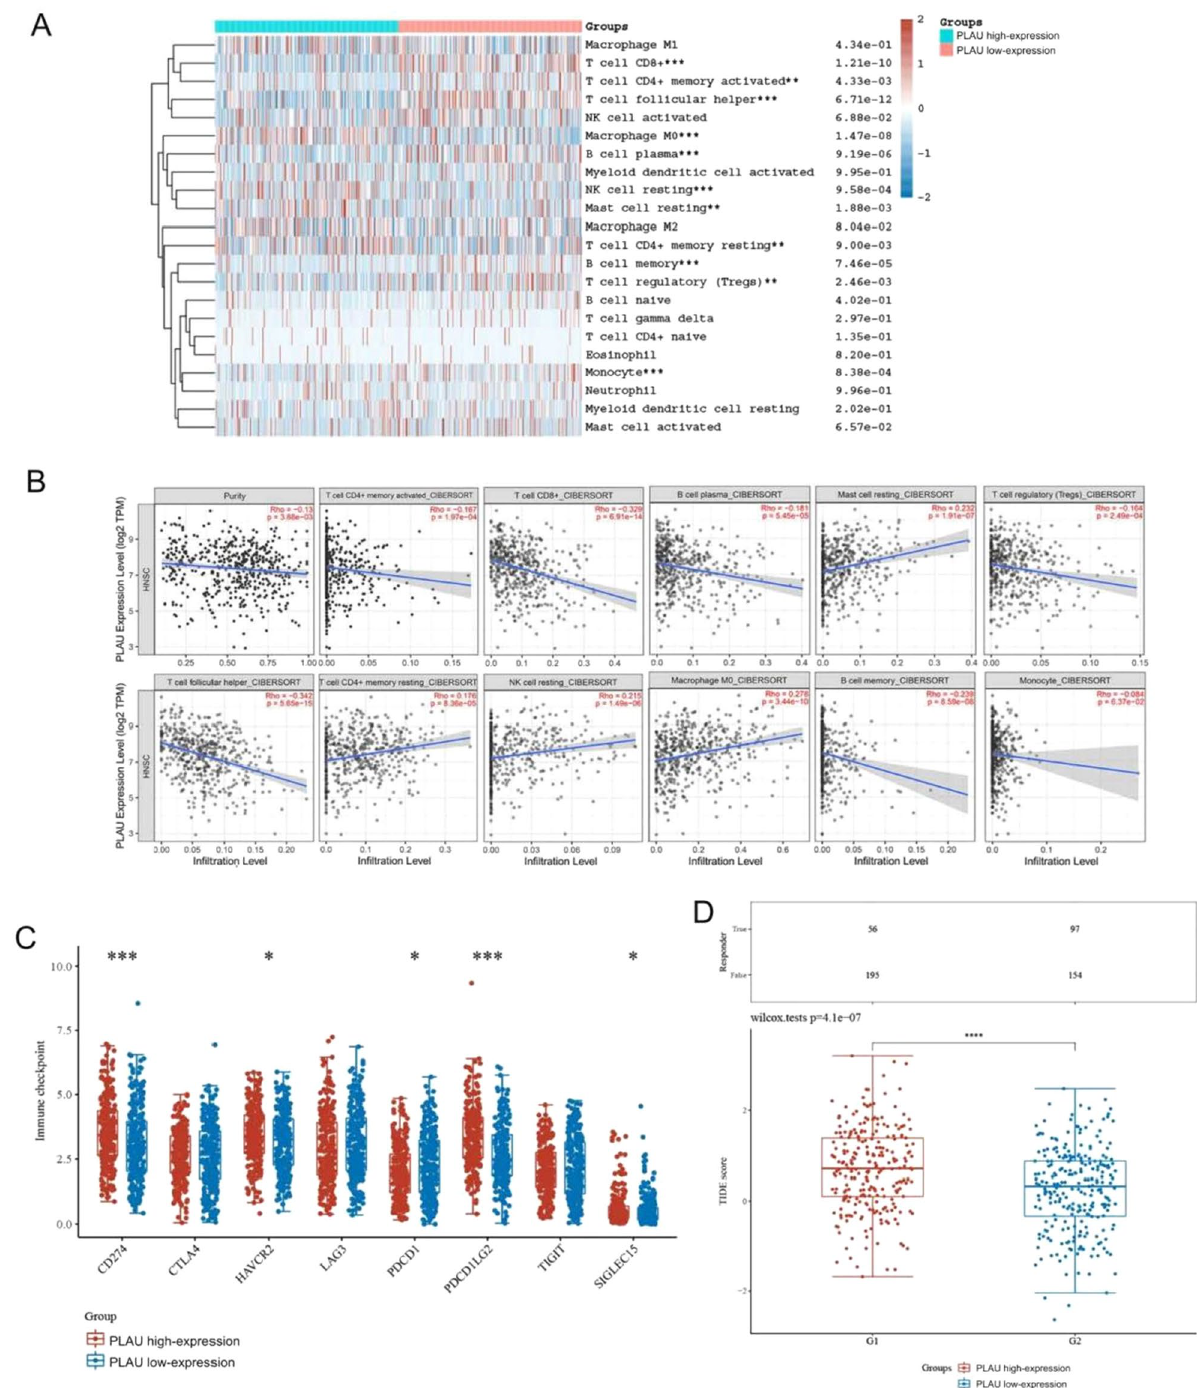
Figure 10. ( A ) Immune cell score heatmap, clustered by their relative expression of the PLAU. ( B ) Correlation between PLAU expression and immune infiltration levels. ( C ) The distribution of 8 immune checkpoint genes’ expression in high- and low-PLAU expression of HNSCC. ( D ) TIDE scores between high- and low-PLAU expression of HNSCC. *p < 0.05, **p < 0.01, ***p <